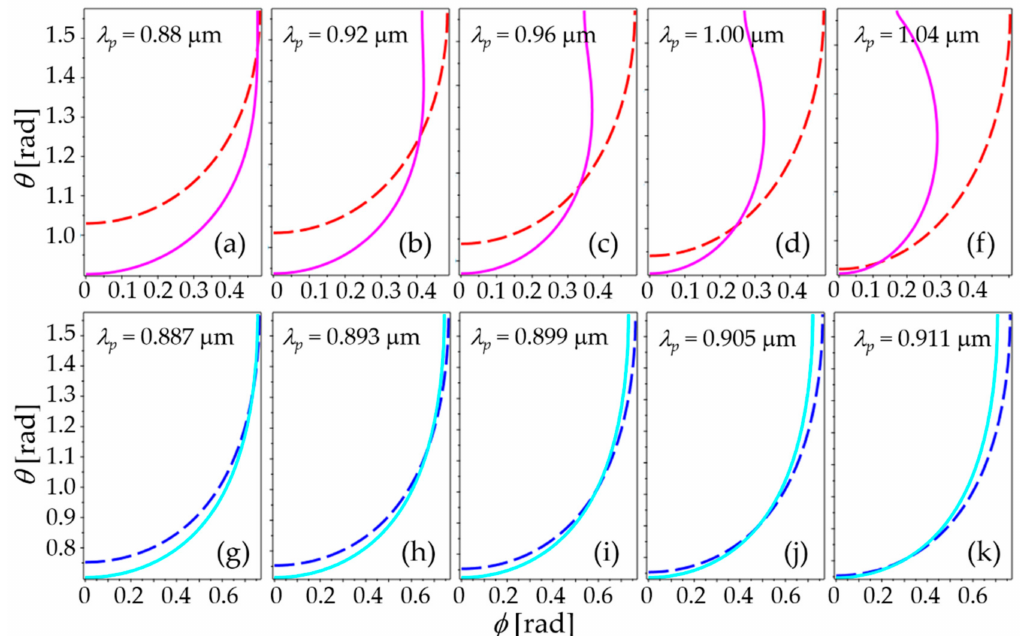
Figure 2. Numerical simulation results of the PM and GV matchings for Type I ( a – f ) and Type II ( g – k ). → k -directions ( θ and φ ) that satisfy the PM and GV In each graph, the dotted and solid lines indicate the matching conditions for a given pump wavelength, respectively.